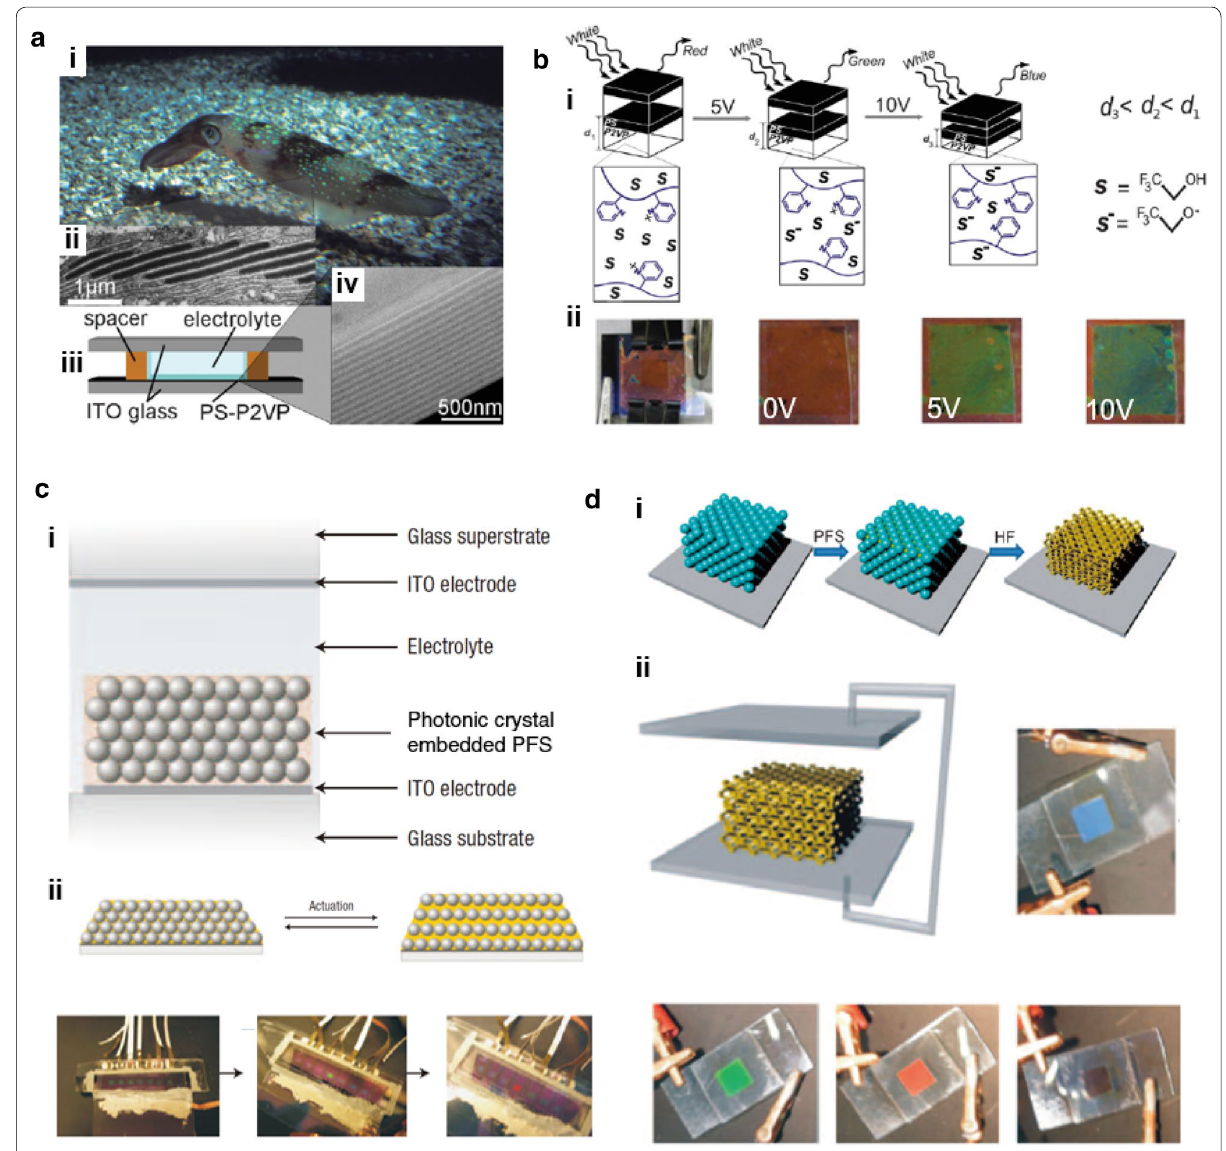
Fig. 9 Electrochemical swelling driven color changes in photonic crystal systems. a Bio‑inspired electroactive color changing 1D photonic crystal display. (i) Digital image of a cephalopod, (ii) protein based multilayer, (iii) A simple electrochemical cell is fabricated by introducing an electrolyte and lamella photonic gel between two ITO coated glass substrates. (iv) a lamella structure of PS‑b‑P2VP block copolymer. b Mechanism of the electrochemical color change, and optical images of the device with various electric potentials. c (i) Schematic of an electrochemical cell with 3D opal photonic crystals in polyferrocenylsilane (PFS) matrix. (ii) Electrochemical induced swelling leads to color change in the photonic crystal. d (i) Preparation process of PFS‑based inverse opal structure. (ii) The inverse opal based photonic crystal is operated electrochemically (Figure reproduced from a , b [70], Copyright 2009, WILEY‑VCH Verlag GmbH & Co. KGaA, Weinheim; c [73], Copyright 2007, Springer Nature; d [74], Copyright 2009, WILEY‑VCH Verlag GmbH & Co. KGaA,